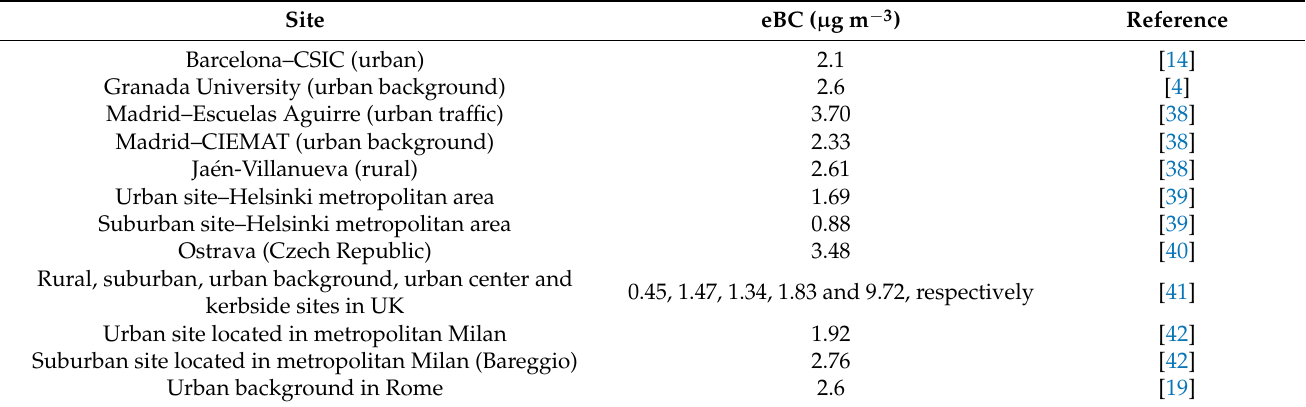
Table 1. Comparison of equivalent black carbon (eBC) ( µ g m − 3 ) in different sites across